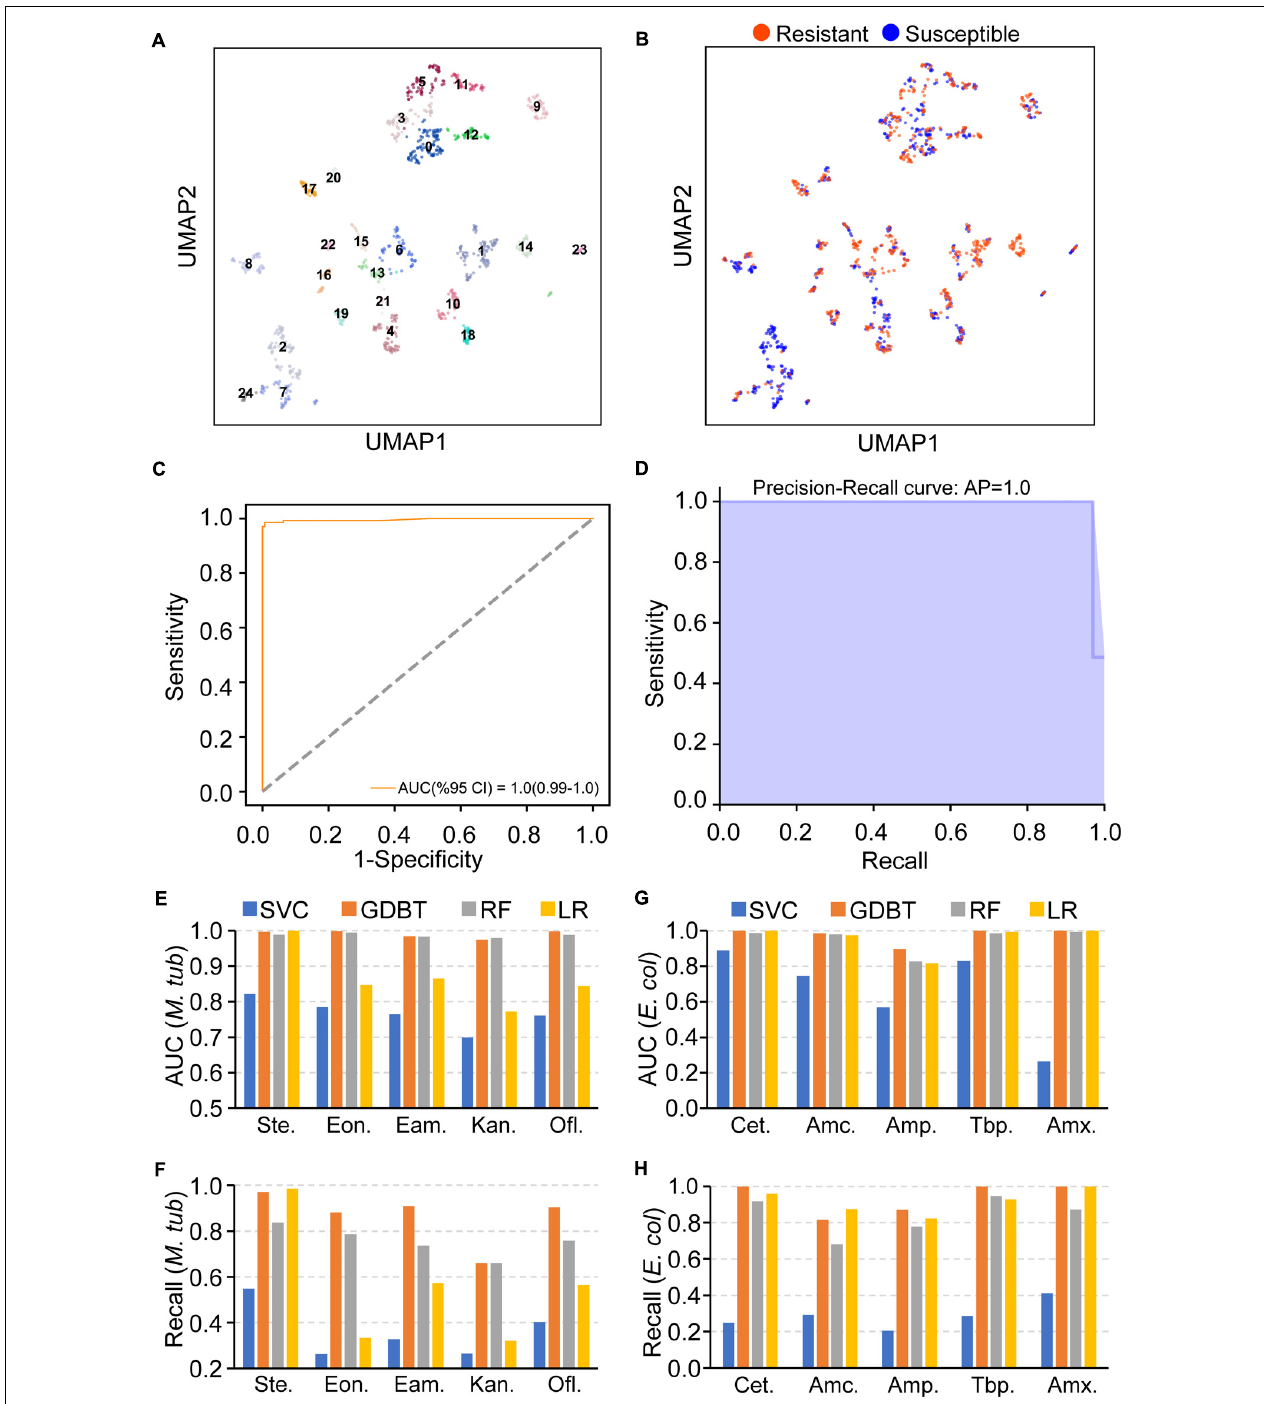
FIGURE 5 | PARMAP (Prediction of Antimicrobial Resistance by MAPping genetic alterations in pan-genome) accurately predicts antimicrobial resistance (AMR), in Mycobacterium tuberculosis and Escherichia coli. (A) Clustering analysis of M. tuberculosis strains with and without streptomycin resistance based on gene allele features using the uniform manifold approximation and projection (UMAP), algorithm; each number represents a distinct cluster. (B) Resistant phenotypes of the distinct clusters; orange indicates ciprofloxacin resistance, and blue indicates ciprofloxacin susceptibility. (C) Receiver operating characteristic (ROC) and (D) precision-recall (PR), curves of streptomycin resistance for the gradient boosting (GDBT), model in the testing dataset. (E,F) Area under the curve (AUC) and Recall values of different machine learning models in the training and testing datasets for streptomycin (Ste.), ethionamide (Eon.), ethambutol (Eam.), kanamycin (Kan.), and ofloxacin (Ofl.), resistance in M. tuberculosis . (G,H) AUC and Recall values of different machine learning models in the training and testing datasets for cephalothin (Cet.), AMX-clavulanate (Amc.), ampicillin (Amp.), tobramycin (Tbp.), and amoxicillin (Amx.), resistance in Escherichia coli .